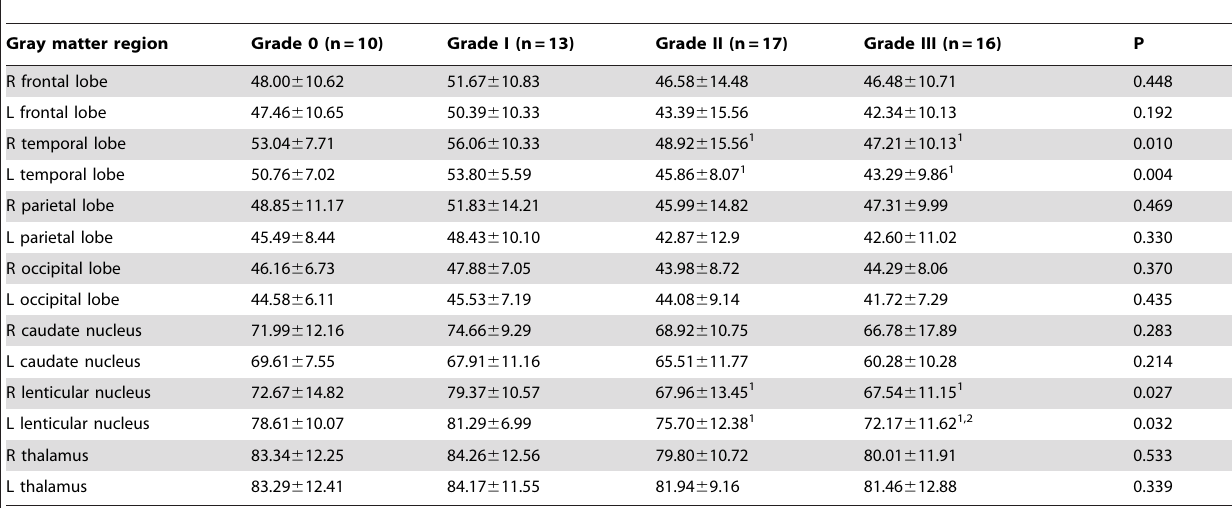
Table 4. Mean (SD) CBF values (mL/100 g/min) of grey matter regions in each grade.